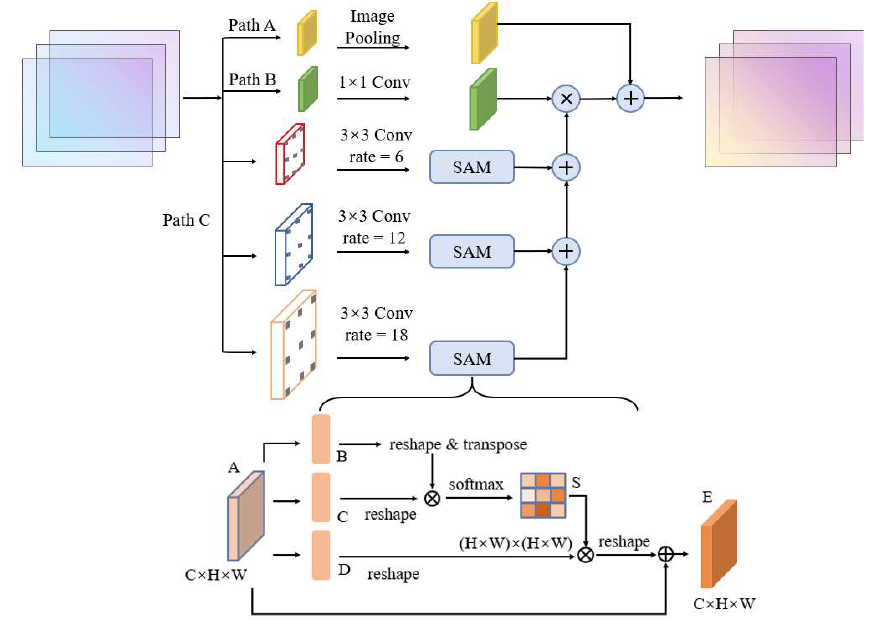
Figure 4. Structure of atrous attention pyramid module in the BGC-Net.